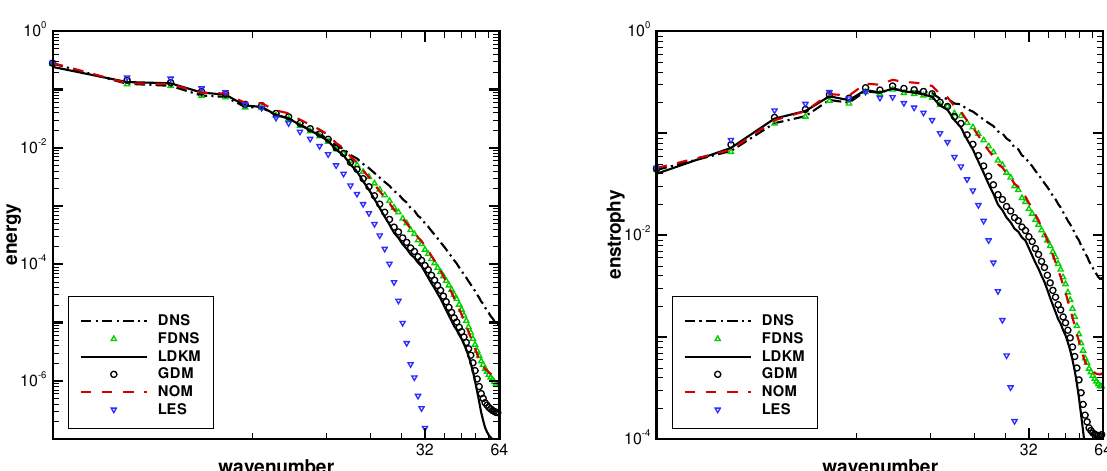
Figure 2. Forced homogeneous isotropic turbulence (HIT): time-averaged energy ( left ) and enstrophy ( right ) spectra for wavelet-based adaptive large-eddy simulation (WA-LES) with localized dynamic kinetic-energy model (LDKM) and global dynamic model (GDM), compared to pseudo-spectral direct numerical simulation (DNS), wavelet-filtered DNS (FDNS), no-model WA-LES (NOM), and nonadaptive dynamic